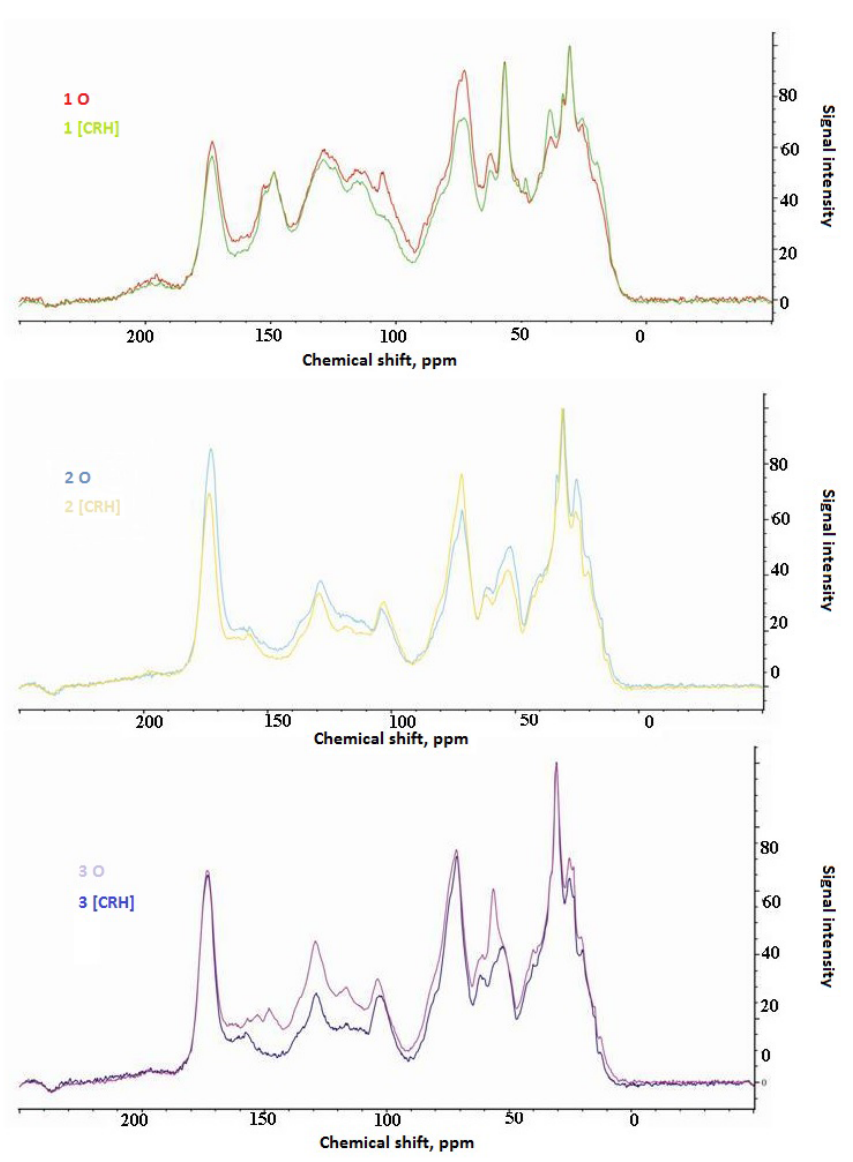
Figure 3. The 13 C-NMR spectra of the HAs, isolated from soils (labelled 1–6 according to Table 1). [CRH] represents the buried humic cryogenic horizon. Table 3. Carbon species integration in molecules of the HAs, %. Sample no.